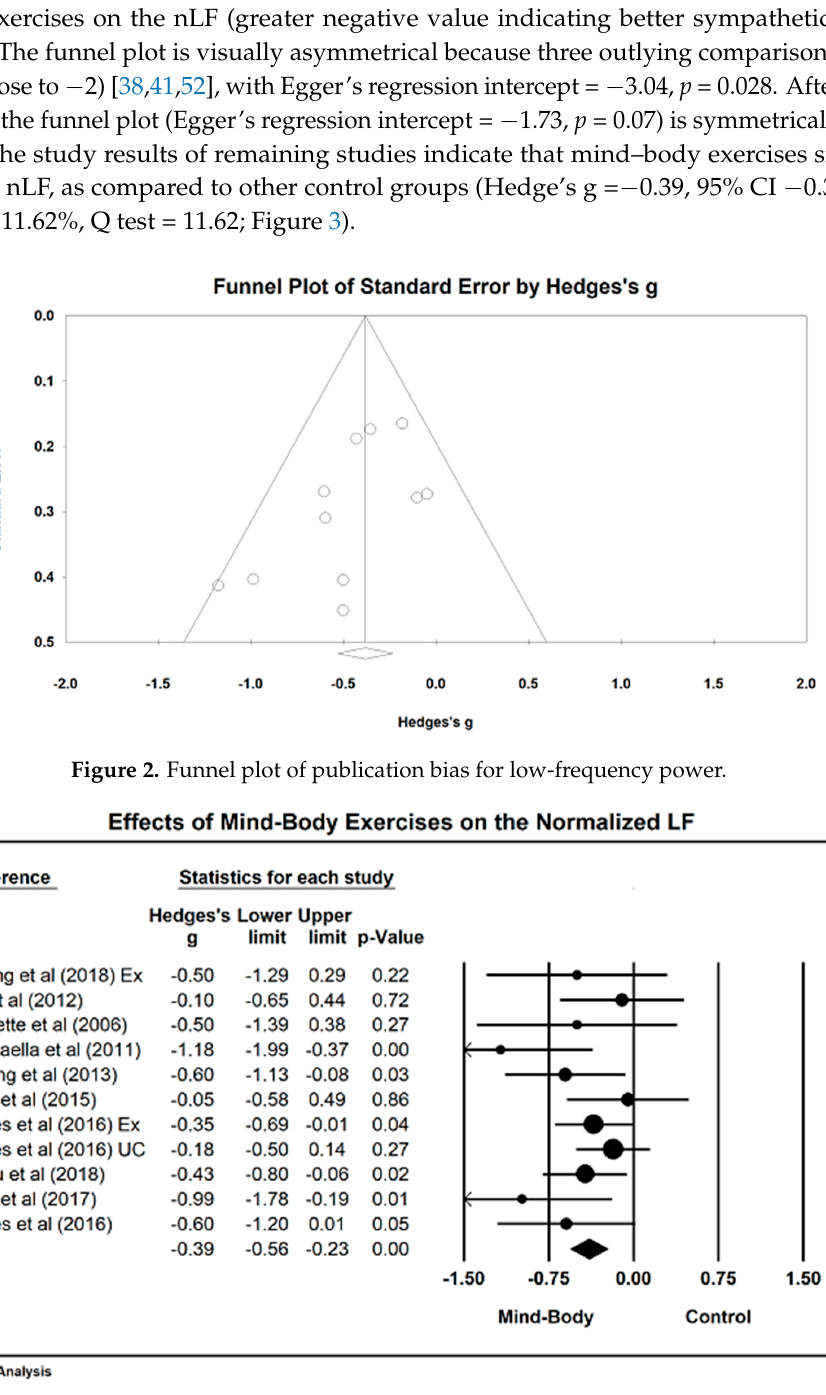
Figure 3. Effects of mind–body exercise on the normalized low-frequency power (LF = low frequency power; Ex = Exercise control group, UC = usual care).